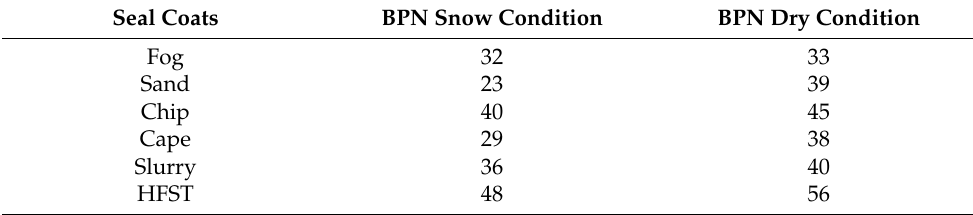
Table 2. Recommended BPNs for the SCS